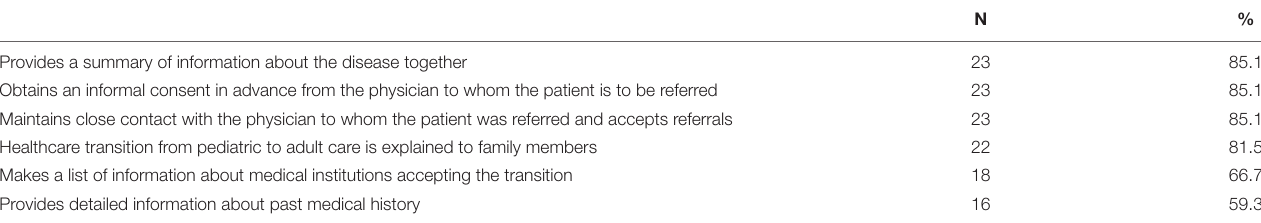
TABLE 2 | Factors facilitating the smooth transition of patients with rare diseases or disabilities ( N = 27, multiple answer).